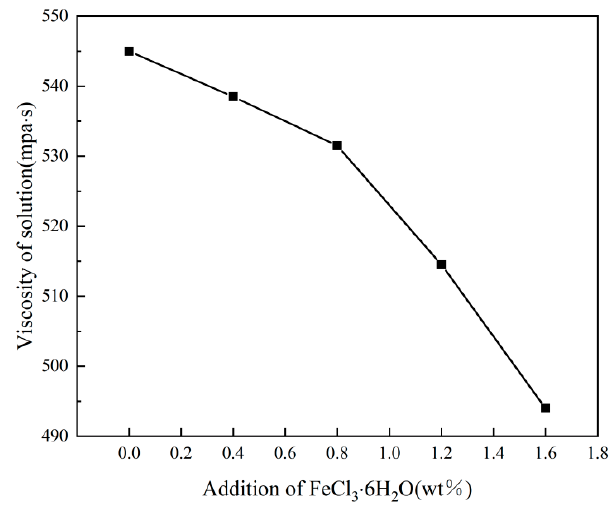
Figure 14. The viscosity of electrospinning solution at different loading of FeCl 3 ·6H 2 O.